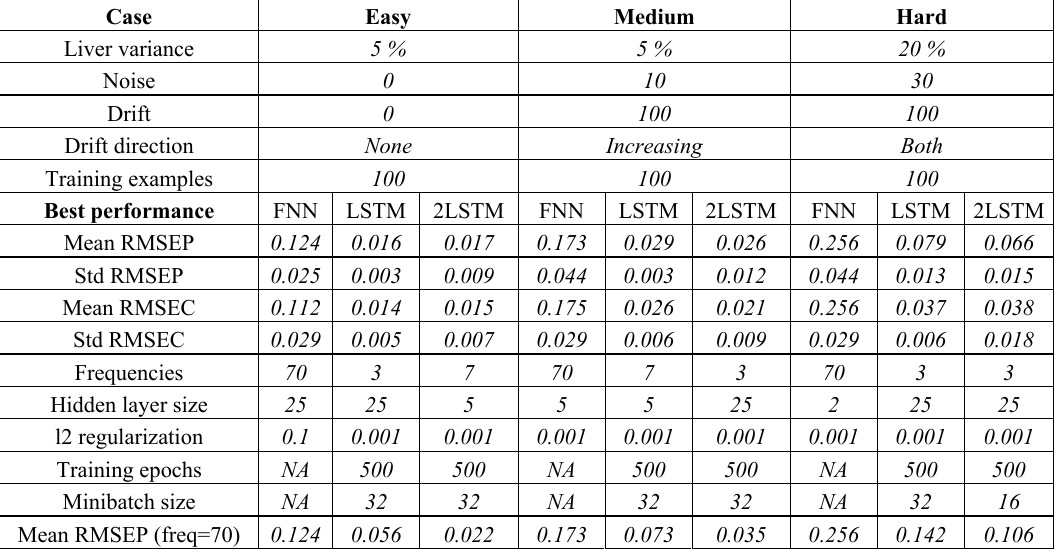
Table 2. Comparison of prediction performance for the different ANN architectures in three different cases of difficulty based on the liver-to-liver variance, noise and drift in the measurement. The selection of input frequencies and hyperparameters for the best prediction performance of the different ANN architectures is provided in the rows below the prediction performances. The last row presents the best prediction performance when all 70 frequencies are used as input to the ANN. RMSEP=root mean square error of prediction, RMSEC=root mean square error of calibration, both having units of ischemia duration in hours.